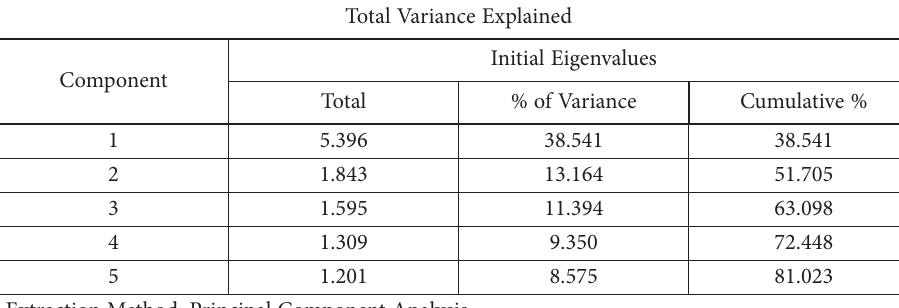
Table 3. Components analysis – model summary